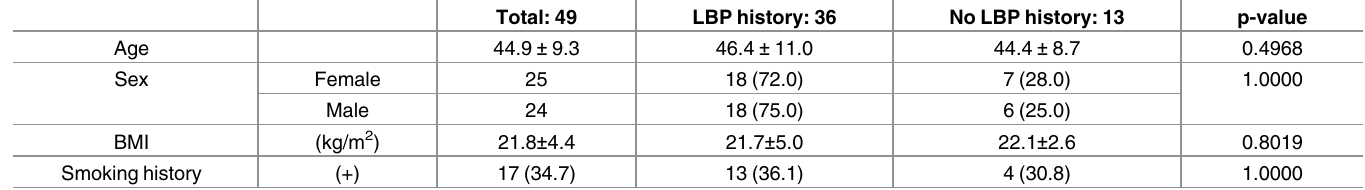
Table 3. Demographic data of participants who did and did not have low back pain history during the 10 yearsbetween the baseline and follow-up study data are shown as mean ± standard deviation or number of participants (%). LBP; low back pain.